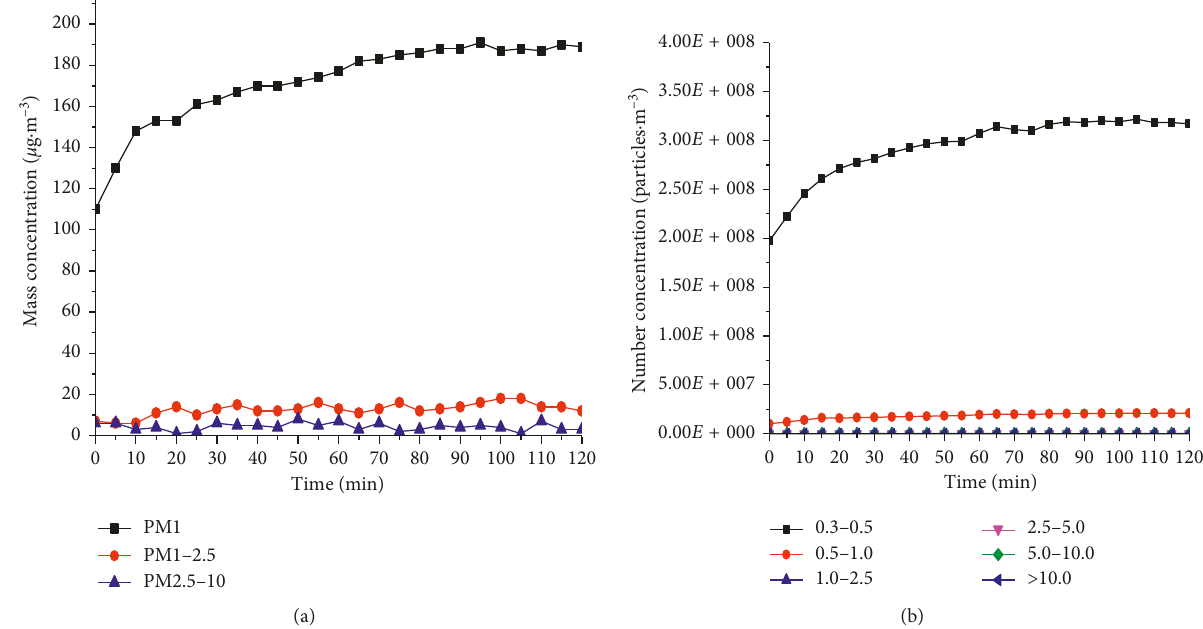
Figure 3: The indoor particle concentration in outdoor PM10 � 300–400 μ g · m − 3 : (a) mass concentration; (b) number concentration.